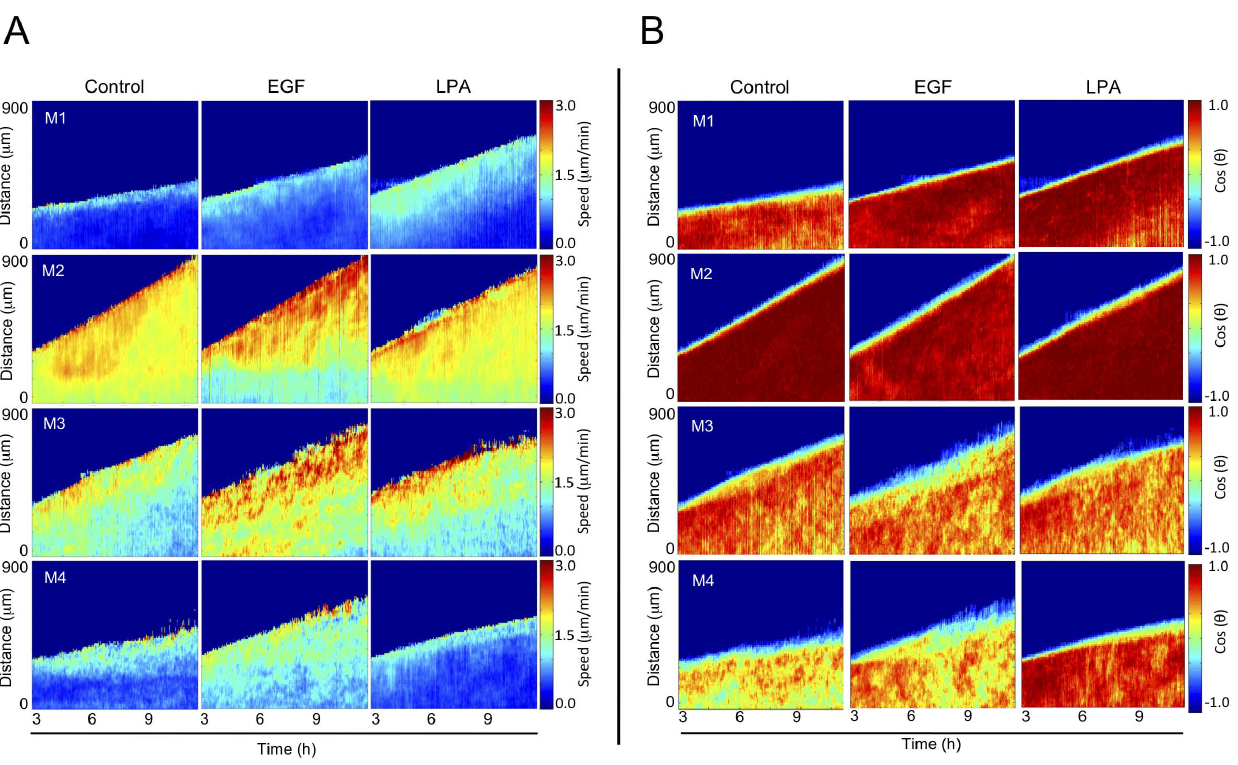
Figure 4. Cell lines of the MCF10A series display distinct spatiotemporal speed and directionality patterns during collective motion. Spatiotemporal heat plots show the average (A) speed and (B) directionality as a function of both position and time from the edge to the center for the sheet. This yielded a spatial map of average speeds and directionalities starting at the sheet edge and moving away, toward the inner regions of the sheet. We defined cos (180 u )=1 (motion directed toward open space) and cos (0 u )= 2 1 (motion directed away from open space). Since cell movement is minimal during the first 3 h, spatiotemporal plots were generated between 3 and 12 h. Cells were stimulated with buffer (control), EGF (5 ng/ml) or LPA (1 m M). Data show heat plots calculated from representative experiments (n=3 for all conditions except M2 with EGF where n=2).